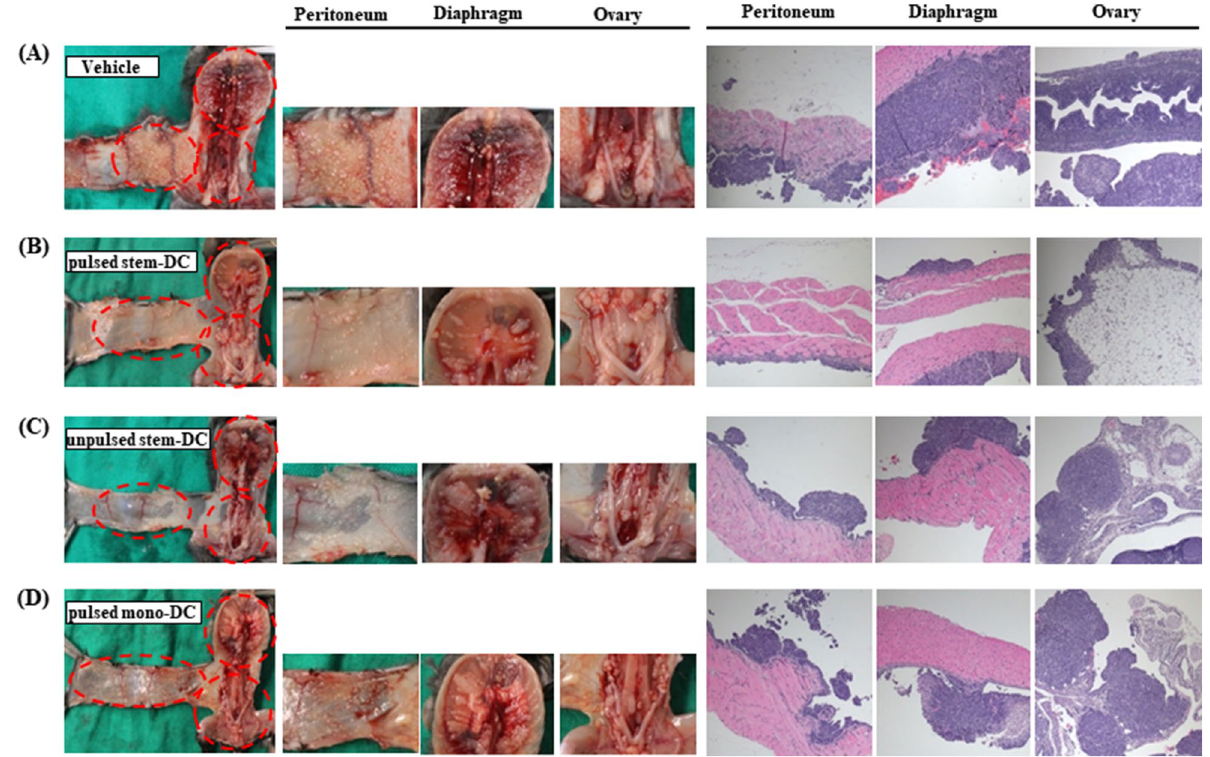
Figure 4. Different volumes of tumor implants according to DC treatments and histopathologic analysis. We intended to show representative images of multiple tumor implants on the peritoneum, diaphragm, and bilateral ovaries. ( A ) The vehicle group showed several tumor implants in the entire abdominal cavity and aggressive tumor invasion in H-E stained tissues. ( B ) Mice treated with pulsed stem-DCs (high dose) showed relatively fewer tumor implants, which were usually confined in the epithelium of each organ. ( C ) The unpulsed Stem-DC group, as a positive control, showed numerous miliary seeding nodules in the peritoneum and clear